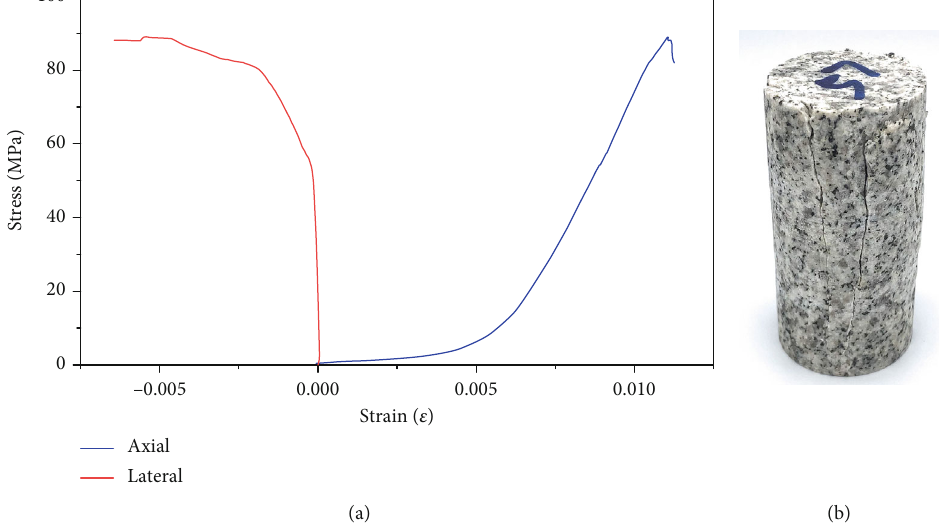
Figure 8: (a) The uniaxial stress-strain curves of granites and (b) the failure type of